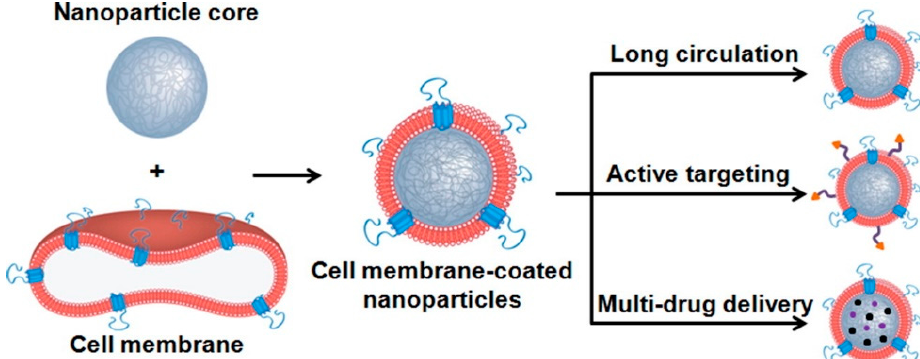
Figure 2. Diagram of membrane camouflaged nanoparticles. Adapted from Brian, T.L. et al., 2015 [118] .